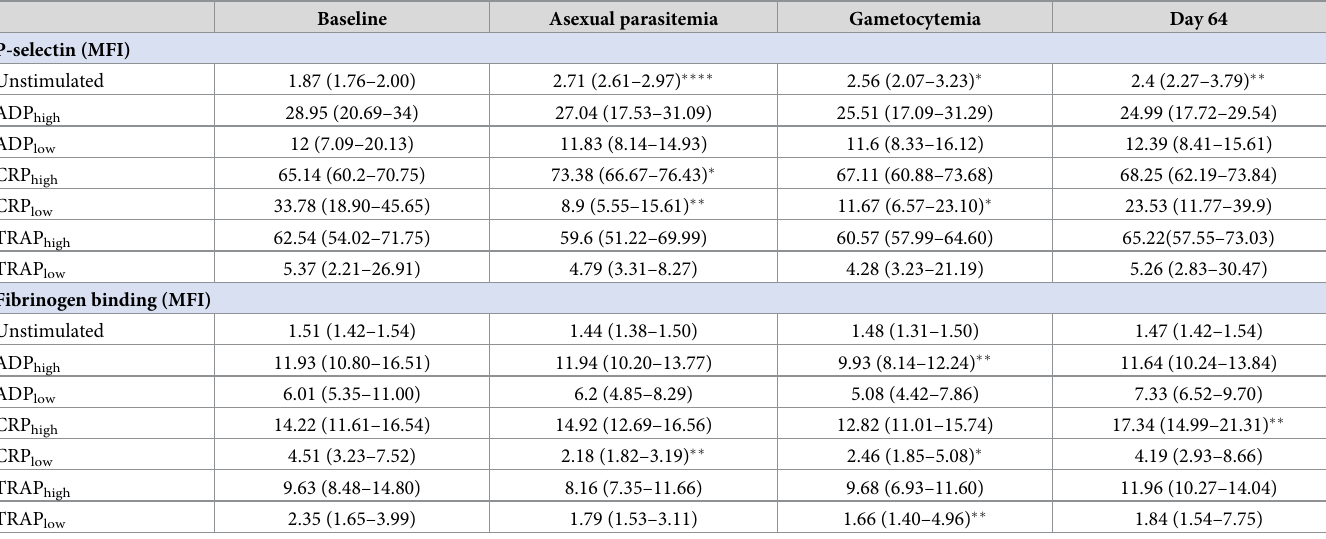
Table 1. Platelet P-selectin expression and platelet-fibrinogen binding in response to ADP, CRP and TRAP in the four stages of plasmodium falciparum